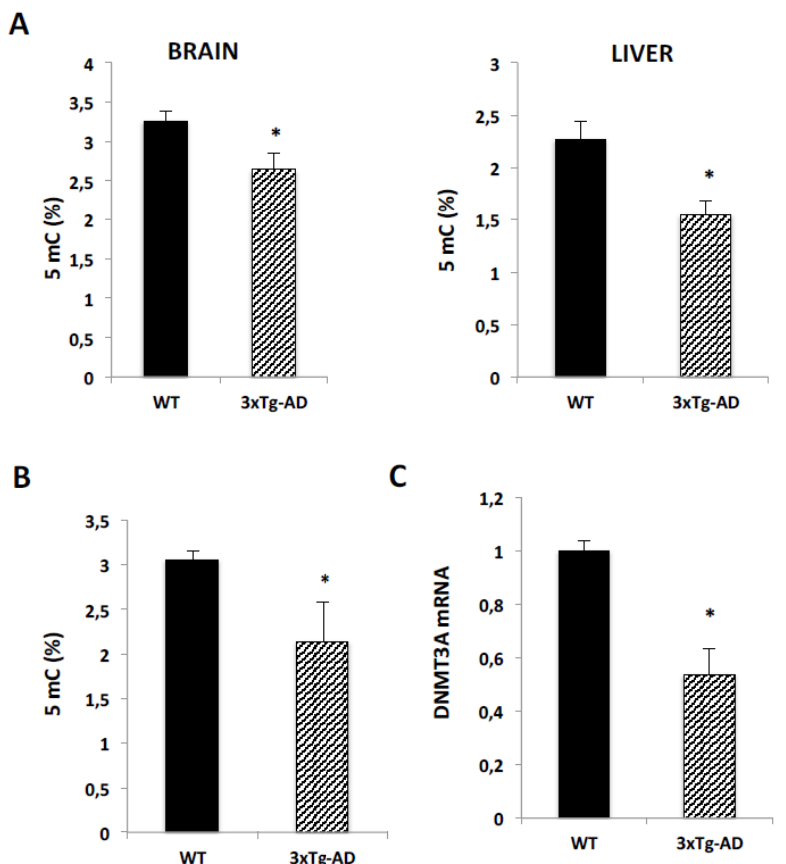
Figure 5. Methylation status study in a 3xTg-AD mice model. ( A ) Global DNA methylation was quantified with an ELISA-like colorimetric kit in brain (left) and liver (right) samples in wild type and 3xTg-AD mice. ( B ) Similar to (A) in serum mice samples. ( C ) Real time RT-qPCR in brain samples of wild type and triple transgenic mice was performed with Taqman probes DNMT3a. All data are means ± S.E.M. and are expressed relative to the values obtained in wild type mice. Significance of ANOVA and Bonferroni post-test among the indicated groups is shown as * p < 0.05.